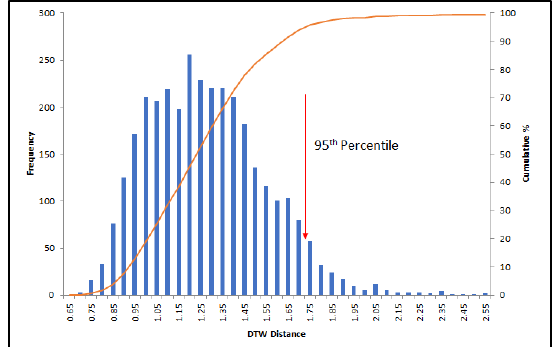
Figure 5. Training data DTW distance histogram.